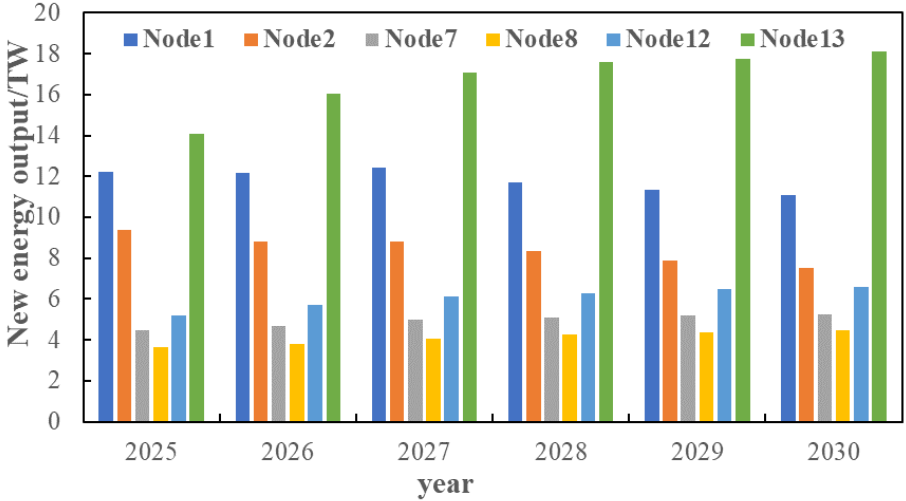
Figure 26. Power output of each power supply in the distribution network from 2025 to 2030.